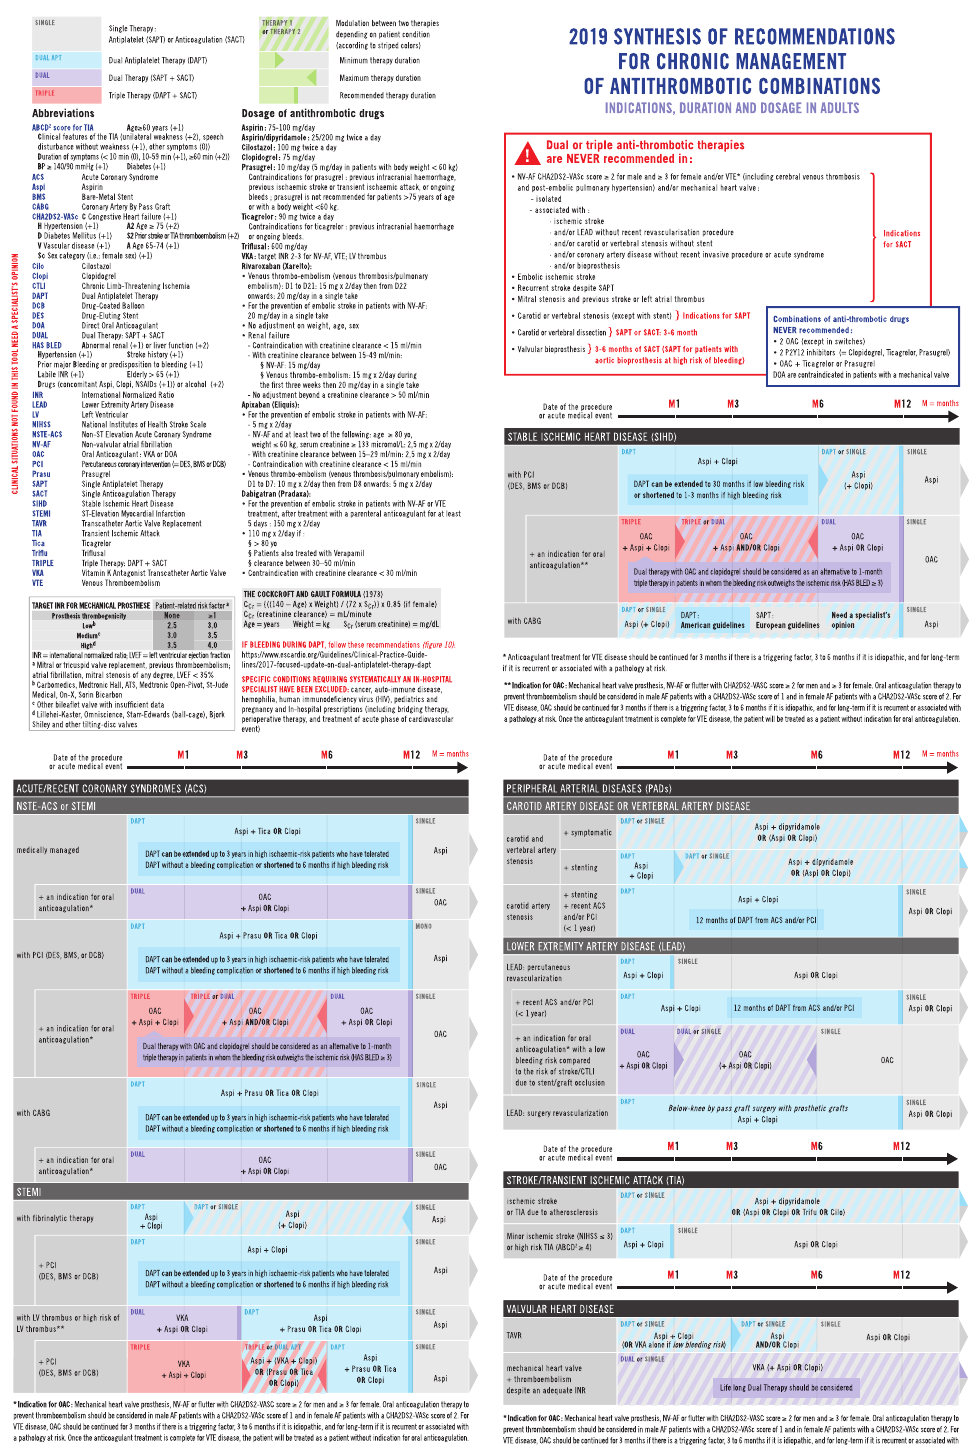
Fig 2. 2019 synthesis of recommendations for combining antithrombotic drugs. Indication, duration and dosage in adult patients.